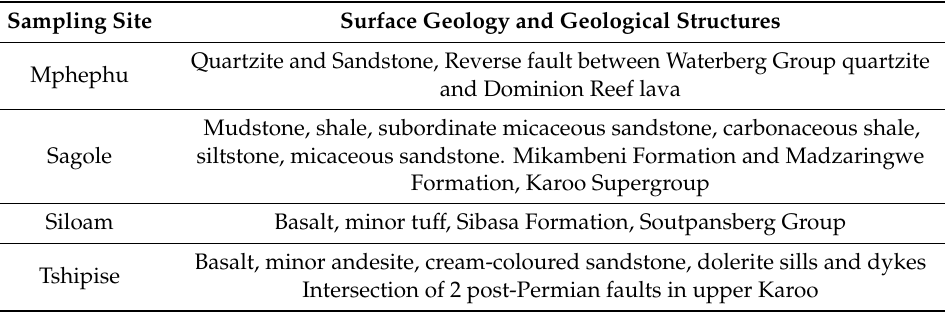
Table 1. Geology and geological structures associated with geothermal